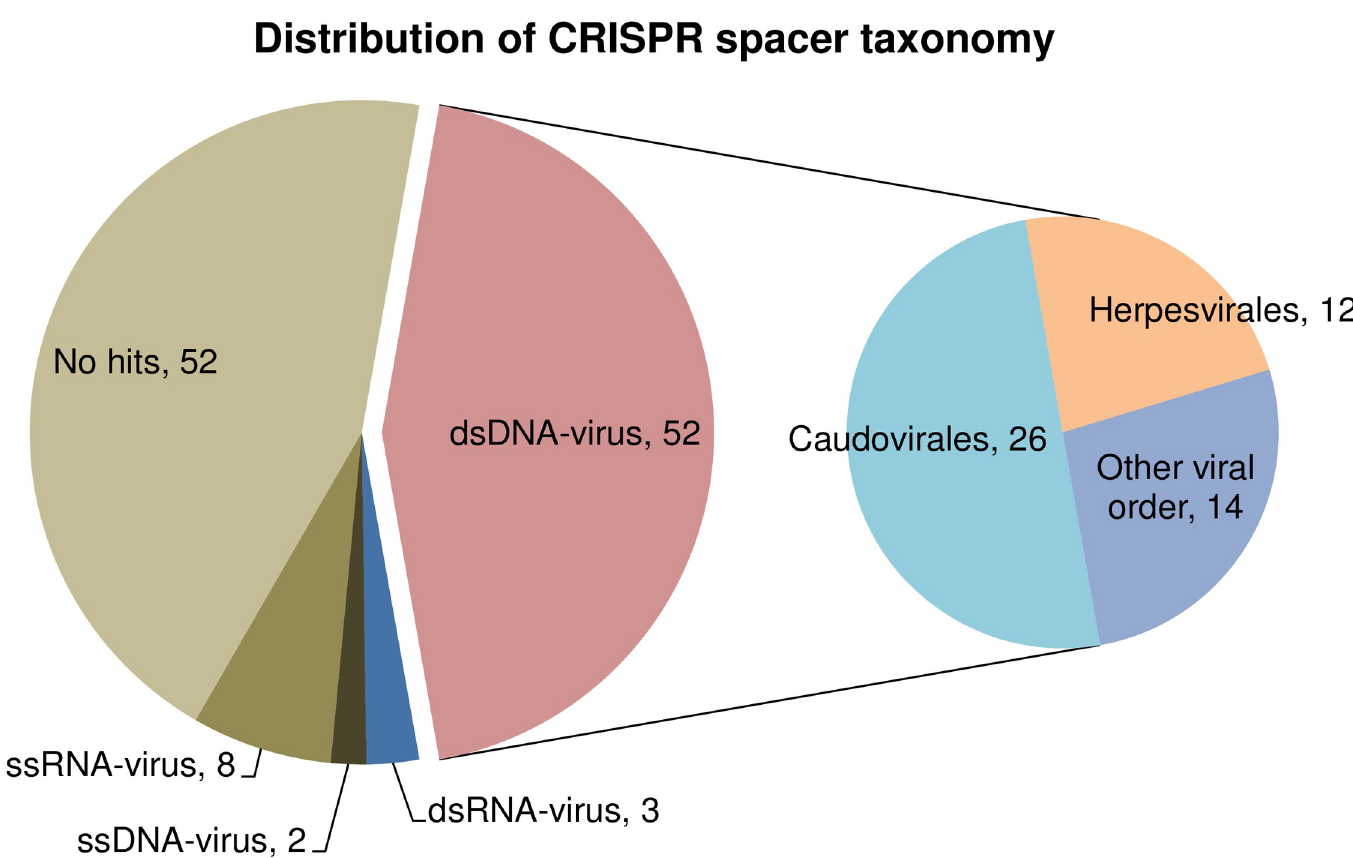
Fig 10. Taxonomic distribution of clustered regularly interspaced short palindromic repeat (CRISPR) spacers.